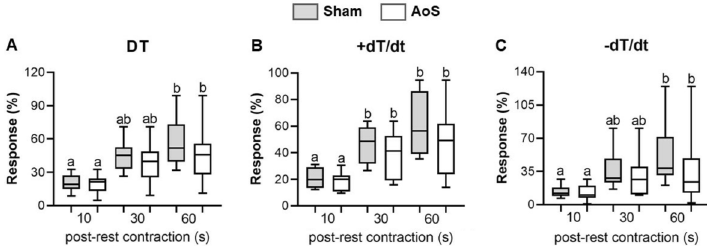
Figure 4. Percent of post-rest contraction from baseline (Ca 2 + concentration: 0.5 mM). DT: maximum developed tension; + dT/dt: maximum rate of tension development; – dT/dt: maximum rate of tension decline. Sham: animals submitted to simulated surgery (n=10); AoS: animals submitted to aortic stenosis surgery (n=10). Data are reported as median, maximum, and minimum. P o 0.05, Sham vs AoS (Kruskall Wallis and Wilcoxon tests complemented by Dunn post hoc test). Different letters indicate statistical difference among the moments within each group.